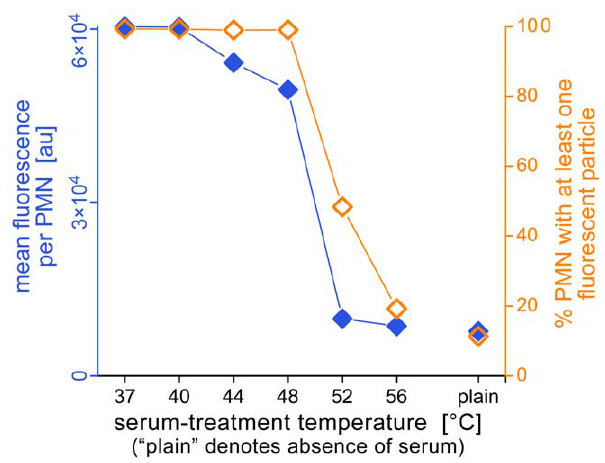
Figure 6. Example measurements of the uptake of fluorescent zymosan particles by human neutrophils. Fluorescence data such as shown in Fig. 5C were used to determine the mean fluorescence per neutrophil (this average includes all neutrophils), as well as the fraction of neutrophils that have associated with at least one zymosan particle, as a function of the serum-treatment temperature.